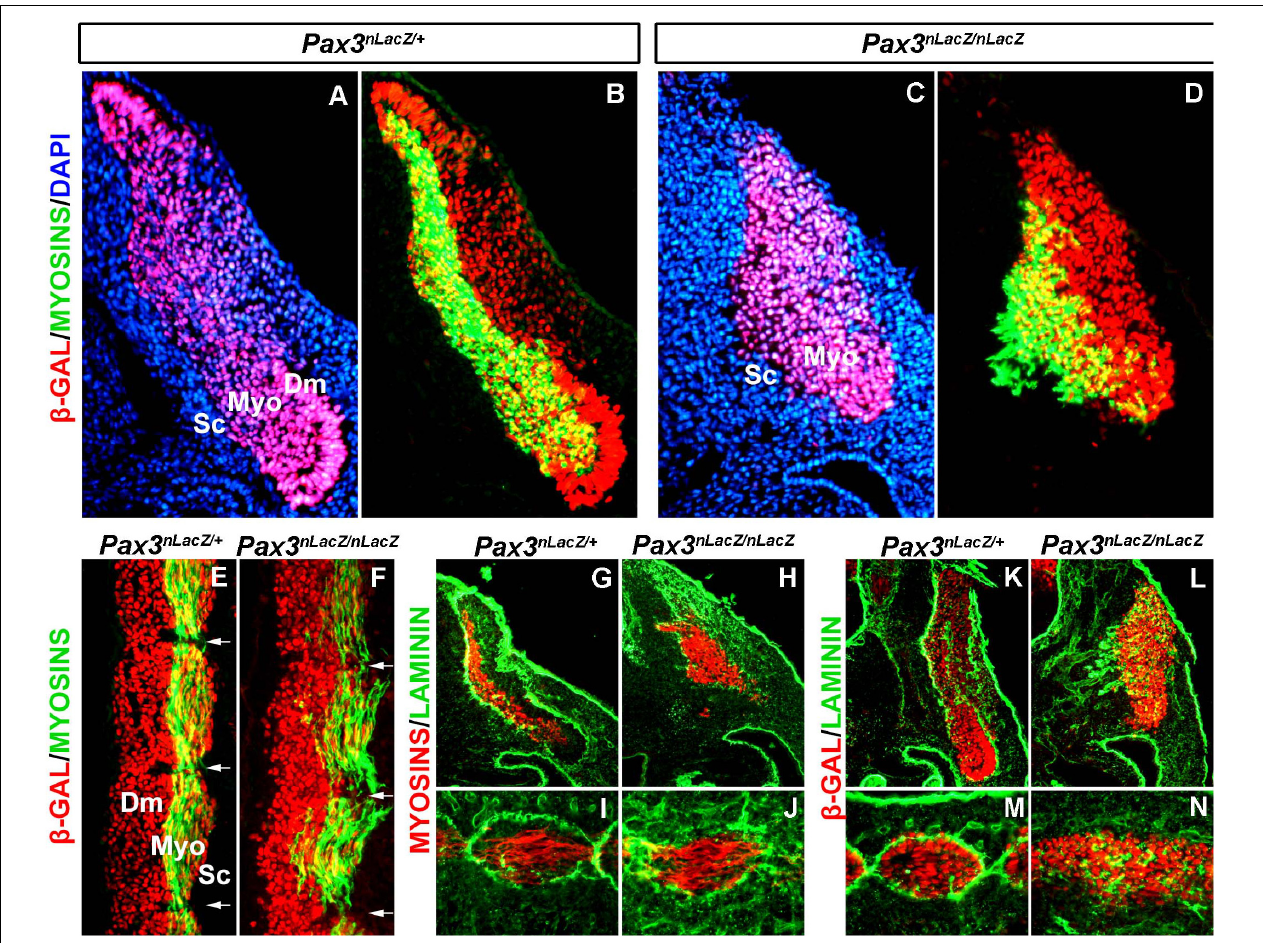
FIGURE 2 | Characterization of the basal lamina in the myotome of Pax3 -mutant embryos. (A–D) Immunostaining on transverse sections at the anterior thoracic level of E11.5 embryos to visualize myosins (green), β -GAL (red) that labels the PAX3 genetic lineage and DAPI to visualize the nuclei (blue) in control ( Pax3 nLacZ / + ) (A,B) and Pax3 -mutant ( Pax3 nLacZ / nLacZ ) (C,D) embryos (Dm, dermomyotome; Myo, myotome; Sc, sclerotome). (E,F) Immunostaining on longitudinal sections (thoracic somites) of E11.5 embryos to visualize muscle Myosins (green) and β -GAL (red) that labels cells that have or would have expressed Pax3 in control ( Pax3 nLacZ / + ) (E) and Pax3 -mutant ( Pax3 nLacZ / nLacZ ) (F) embryos (Dm, dermomyotome; Myo, myotome; Sc, sclerotome). (G,J) Immunostaining on transverse (G,H) and longitudinal (I,J) sections of E11.5 embryos to visualize muscle Myosins (red) and Laminin (green) in control ( Pax3 nLacZ / + ) (G,I) and Pax3 -mutant ( Pax3 nLacZ / nLacZ ) (H,J) embryos. (K,N) Immunostaining on transverse (K,L) and longitudinal (M,N) sections (thoracic somites) of E11.5 embryos to visualize β -GAL that labels the PAX3 genetic lineage (red) and Laminin (green) in control ( Pax3 nLacZ / + ) (K,M) and Pax3 -mutant ( Pax3 nLacZ / nLacZ ) (L,N)